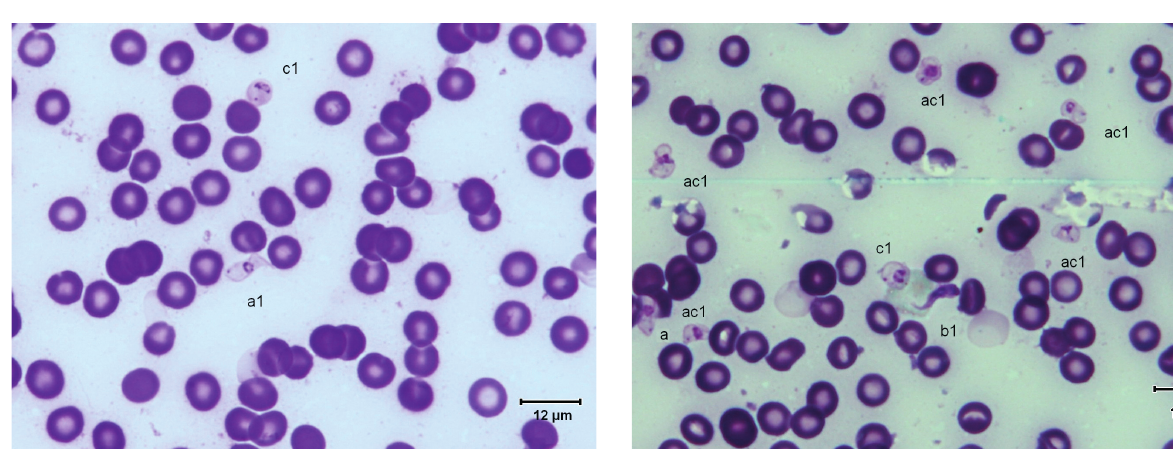
Fig. 7. – Typical T. (Nannomonas) hyperpachymorph (a1) and sphaeromorph (“amastigote”-form) (c1). Photo by Marc Des- quesnes.